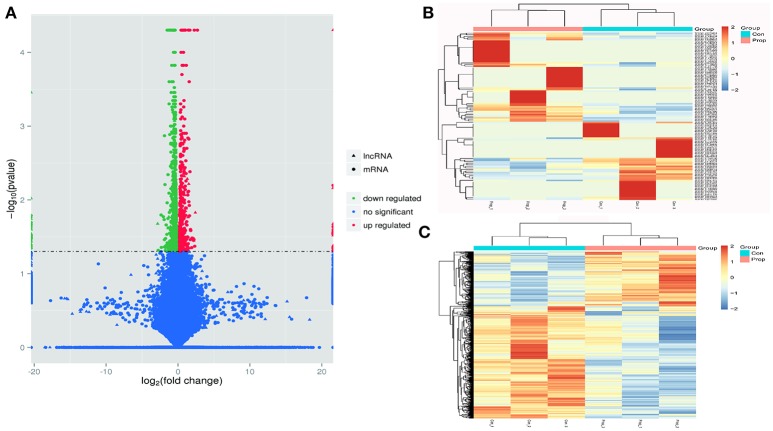
Transcriptome profile of RNA-Seq data distinguishing control and propofol groups. (A) A volcano plot of differentially expressed lncRNAs and mRNAs between control and propofol groups; (B) Unsupervised hierarchical clustering of the expression profiles of differentially expressed lncRNAs in the propofol group, compared with the control group; (C) Unsupervised hierarchical clustering of the expression profiles of differentially expressed mRNA in the propofol group compared with the control group.